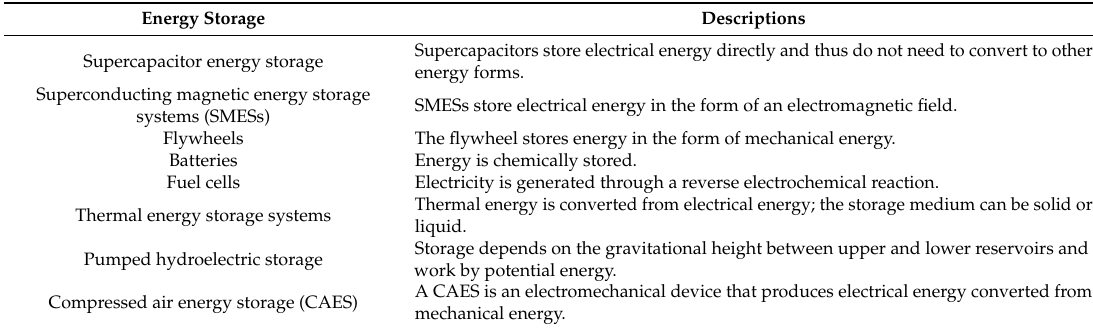
Table 5. Types of energy storage